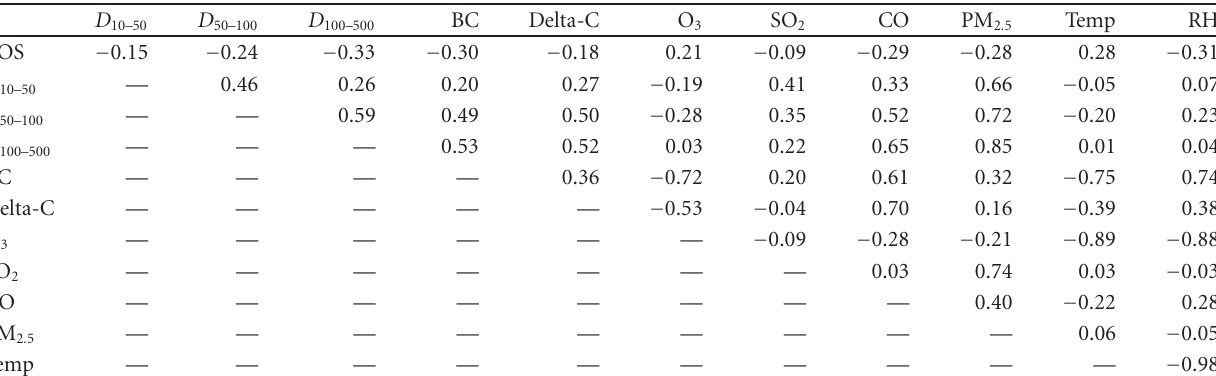
Table 5: Summary of the Pearson correlation coe ffi cients.